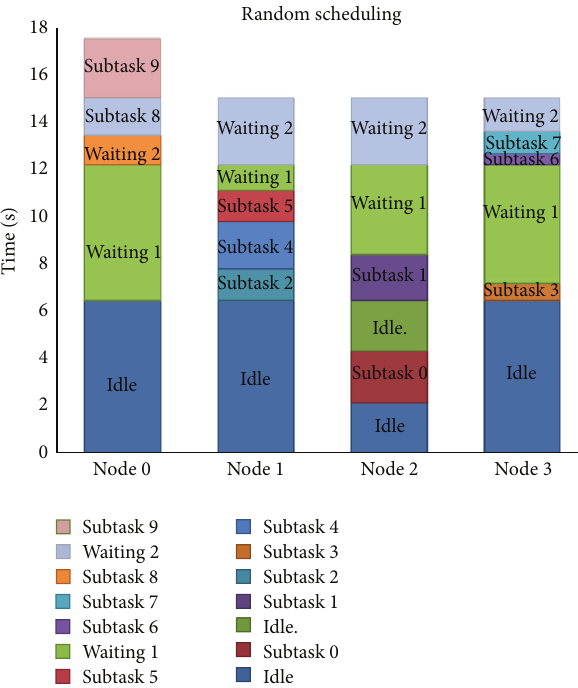
Figure 6: Detailed timewise schedule for all subtasks of DAG based task 𝑡 using random